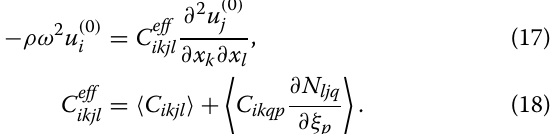
Fig. 1 for angles φ and θ ), (cid:13) −→ (cid:13) (cid:13) (cid:13) (cid:13) = k